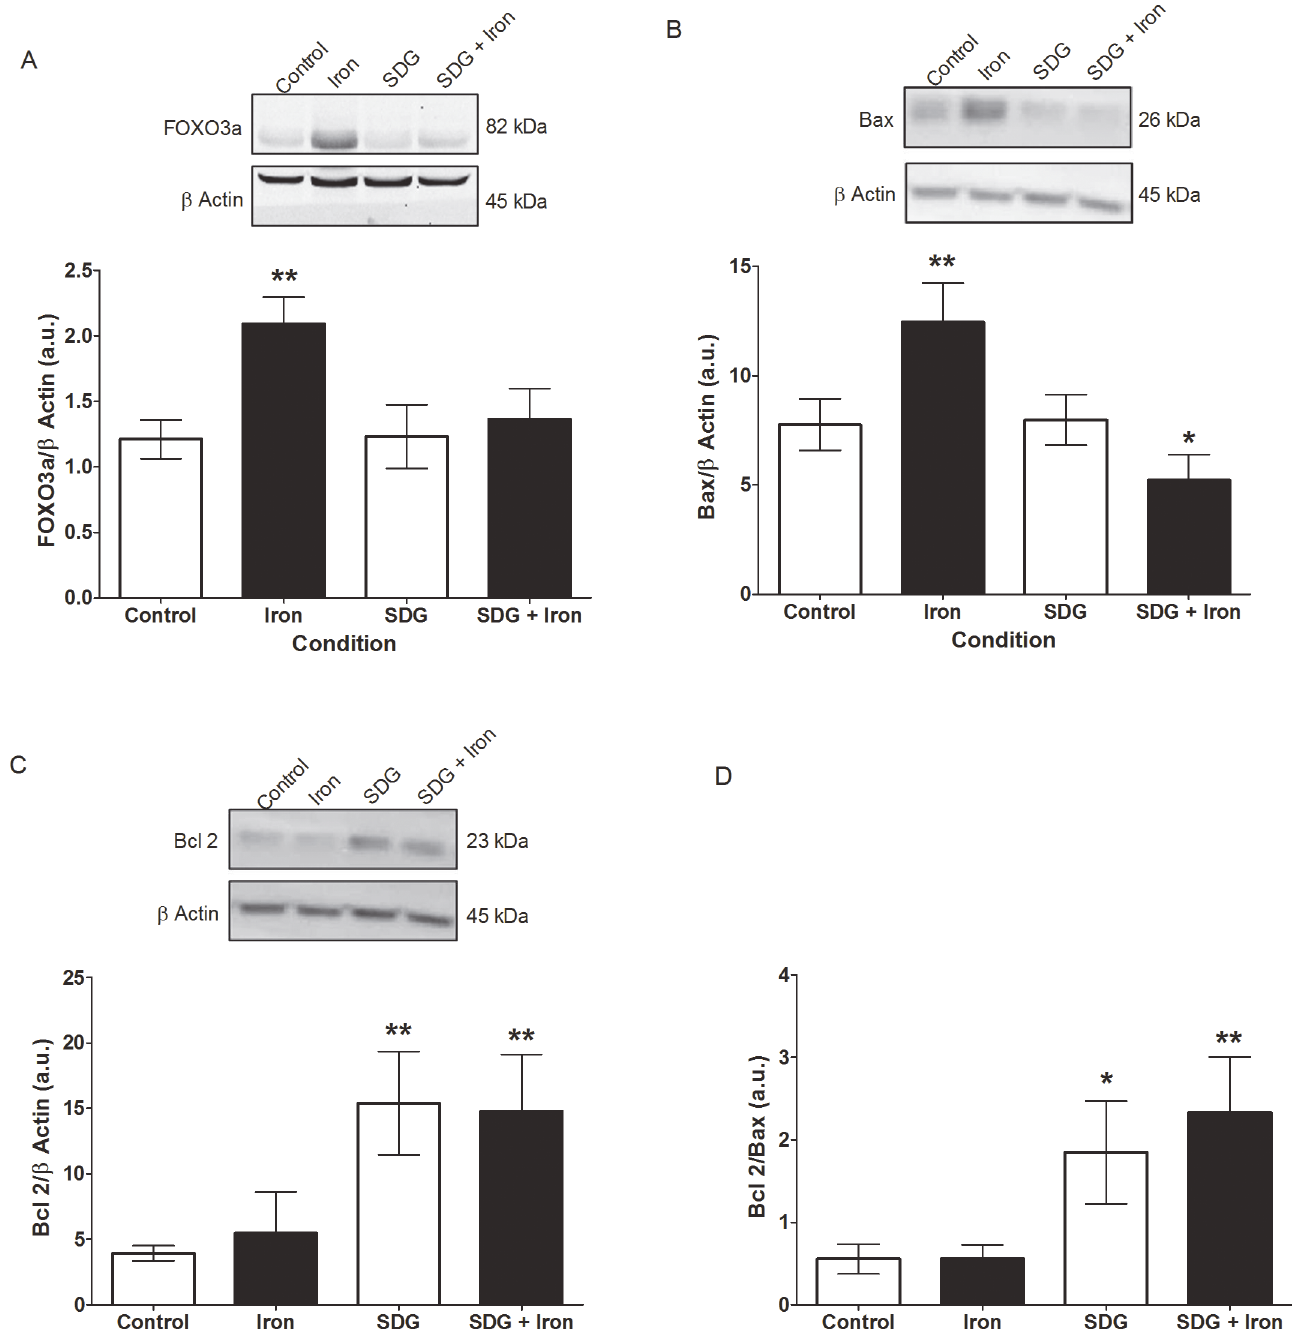
Fig 7. SDG decreases iron-induced apoptosis in H9c2 cells. Forkhead box O (FOXO)3a (A), Bax (B) Bcl2 (C) protein levels and Bcl2/Bax ratio (D) in control, 50 μ M iron-treated, 500 μ M secoisolariciresinol diglucoside (SDG), and SDG pre-treatment + iron-treated H9c2 cells. Protein levels were measured via immunoblotting. Data is expressed as protein/ β -actin arbitrary units (a.u) ( ** = p < 0.01 versus control; * = p < 0.05 versus control, n = 4).